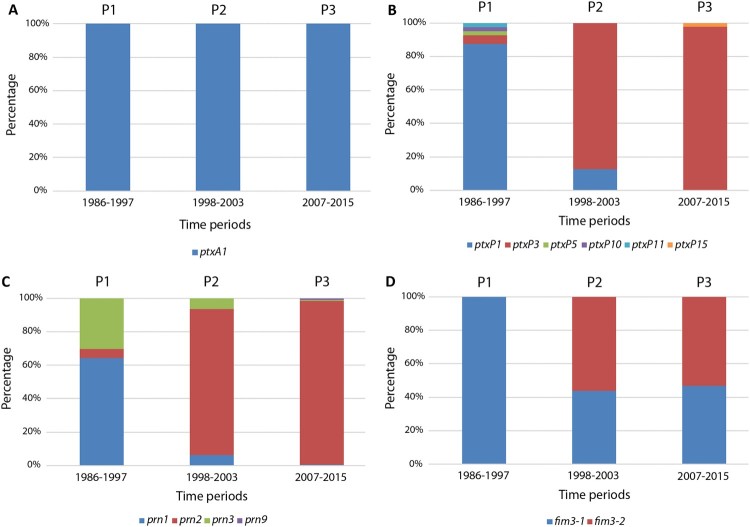
Antigen variants detected in B. pertussis circulating in the metropolitan area of Barcelona from 1986 to 2015. (A) Pertussis toxin. (B) Pertussis toxin promoter type. (C) Pertactin. (D) Type 3 fimbriae. P1: exclusive use of whole cell vaccine; P2: transition from whole cell vaccine to acellular vaccine; P3: exclusive use of acellular vaccine.